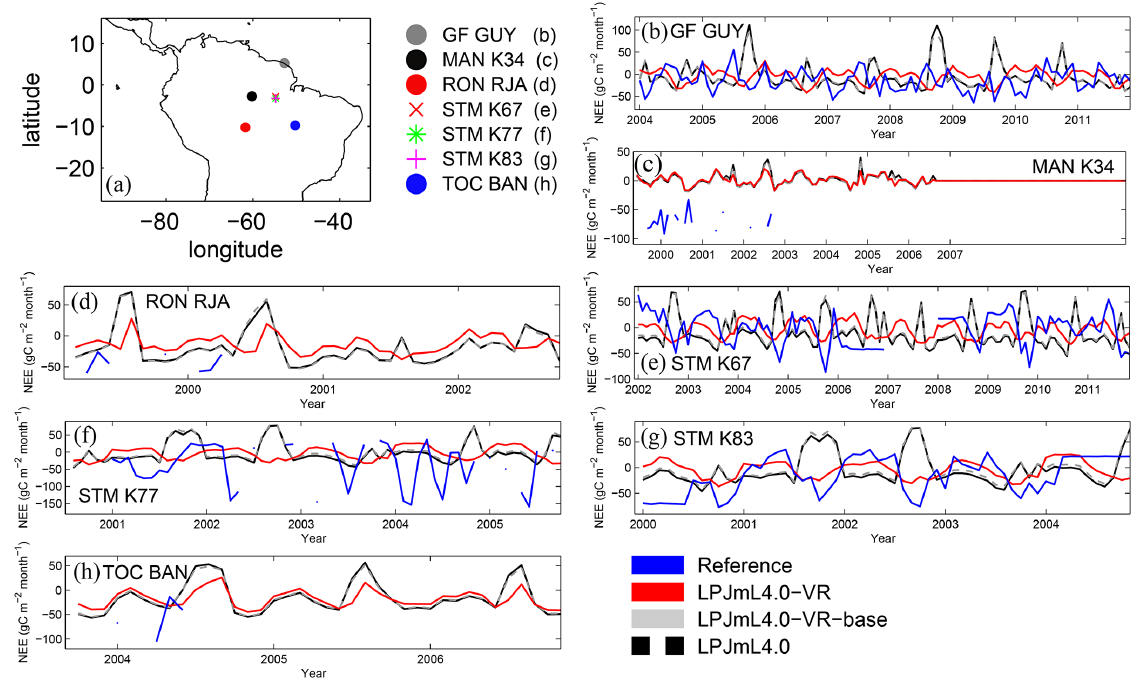
Figure B12. Comparisons of monthly NEE between different FLUXNET sites (Reference; see also Sect. 2.5.1) and respective simulation output of the different LPJmL model versions used in this study forced with CRU climate. (a) Geographical location of different FLUXNET sites (see also Table